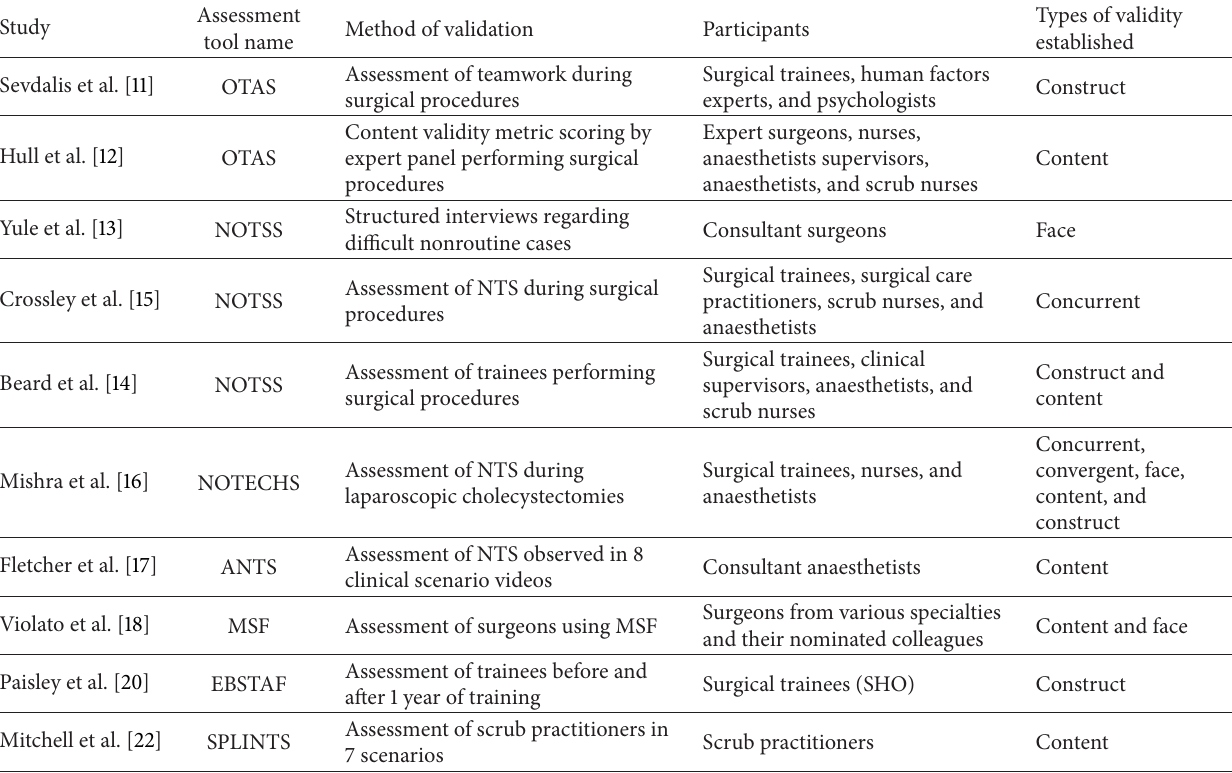
Table 2: Sources of validation evidence for teamwork assessment tools in